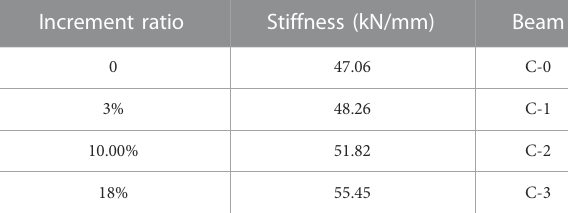
TABLE 9 Initial stiffness for the tested beams (a/d =